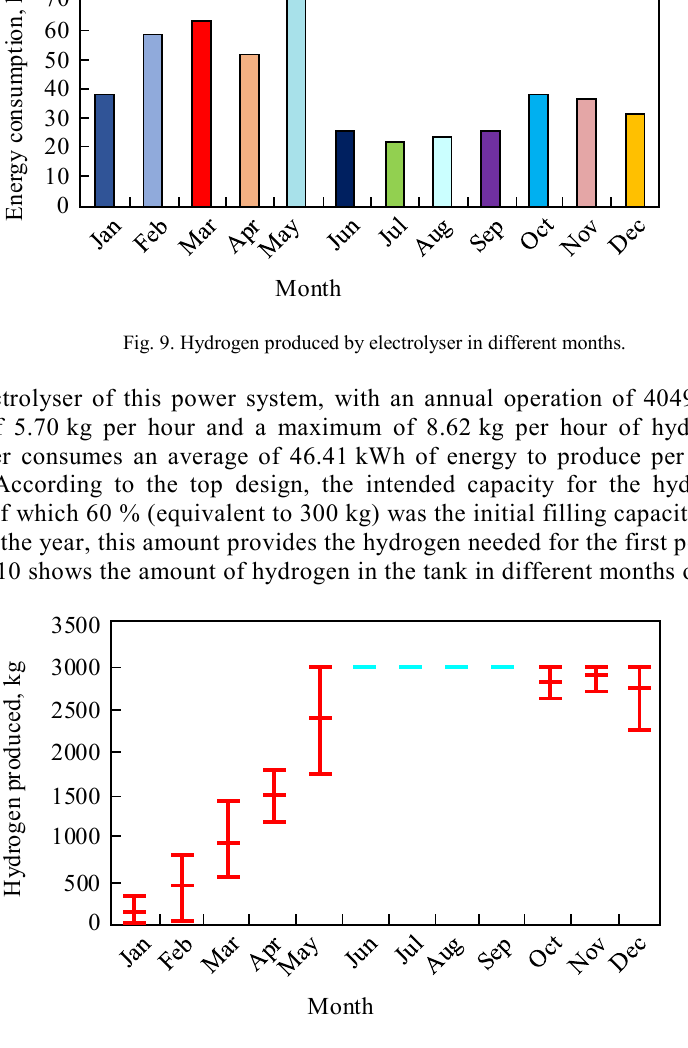
Fig. 10. Hydrogen produced by the electrolyser in different